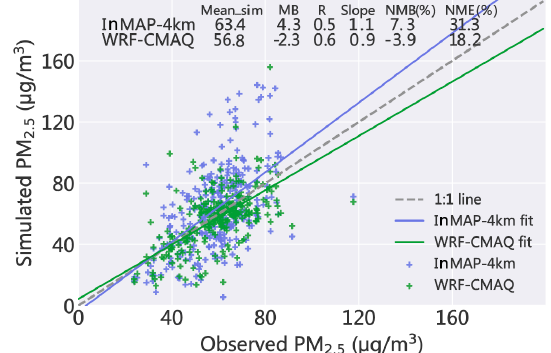
Figure 10. Scatterplot comparing the PM 2 . 5 concentration modeled in the BTH region at a 4km spatial resolution by the InMAP-China and WRF-CMAQ models. The statistical metrics are given in the